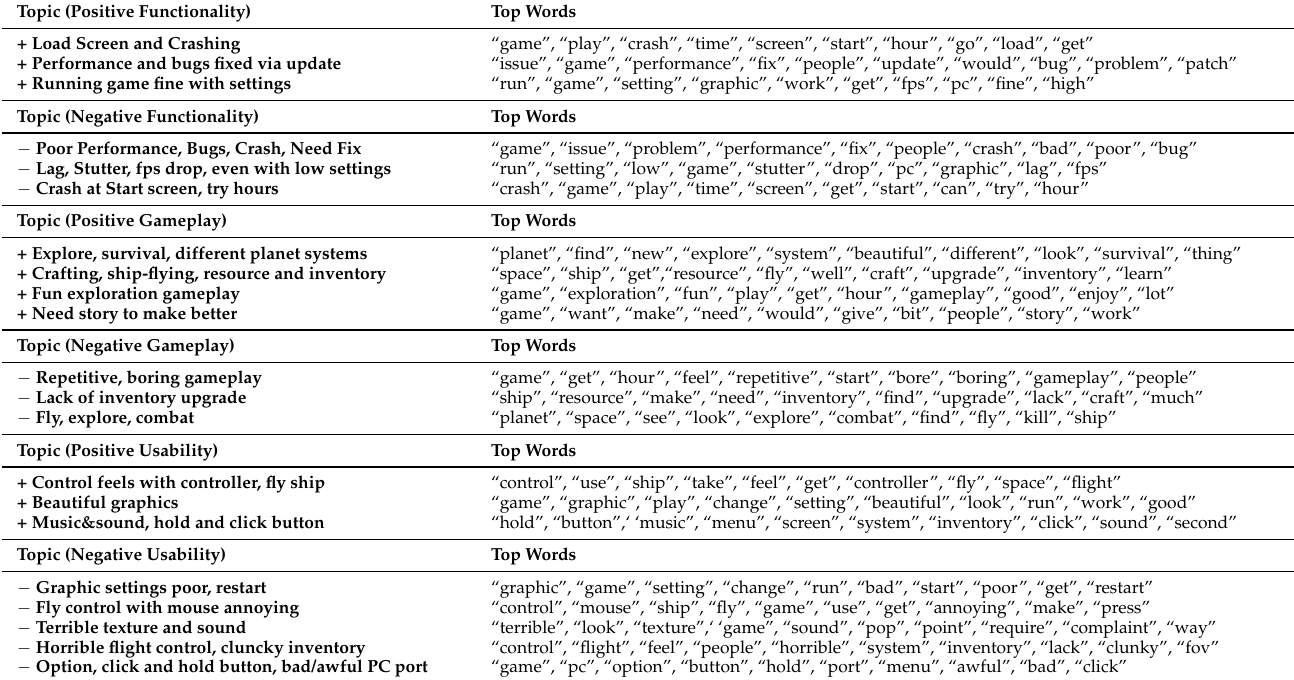
Table 7. Detected topics for each review